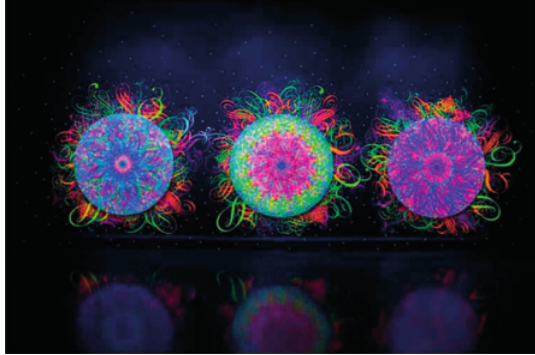
Fig. 2. Ryan McGiness. Black Holes . Caja Madrid, Barcelona, 2008 (McGiness 2011) Note: By taking into account optics and visual physiology, we can create environments that extend the normal range of our visual experiences. Despite its invisibility, we can see the effects of UV light on fluorescent paintings.